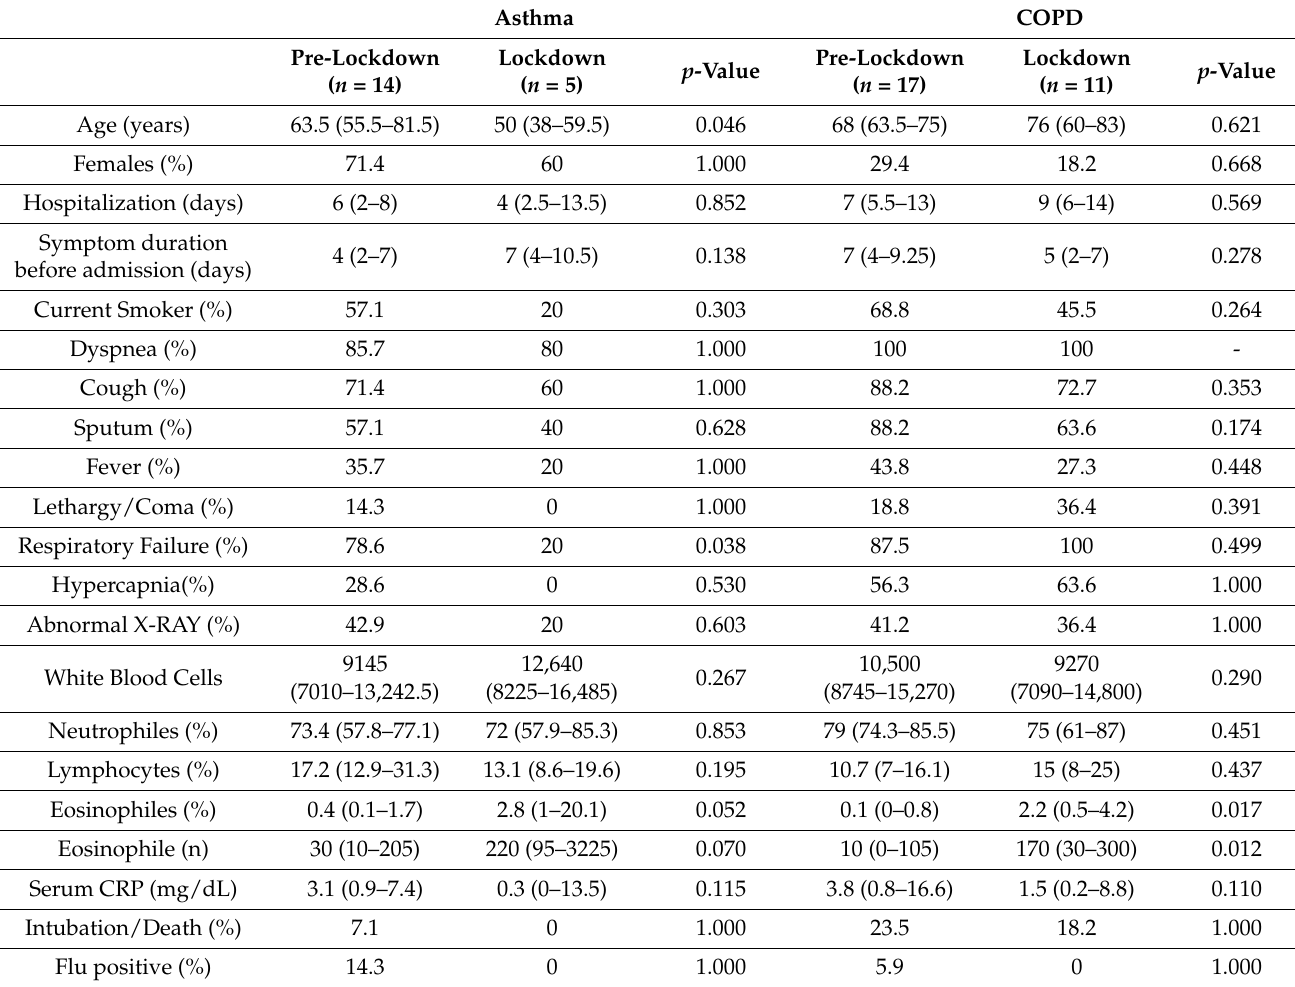
Table 3. Comparisons in admissions between Pre-Lockdown and Lockdown.